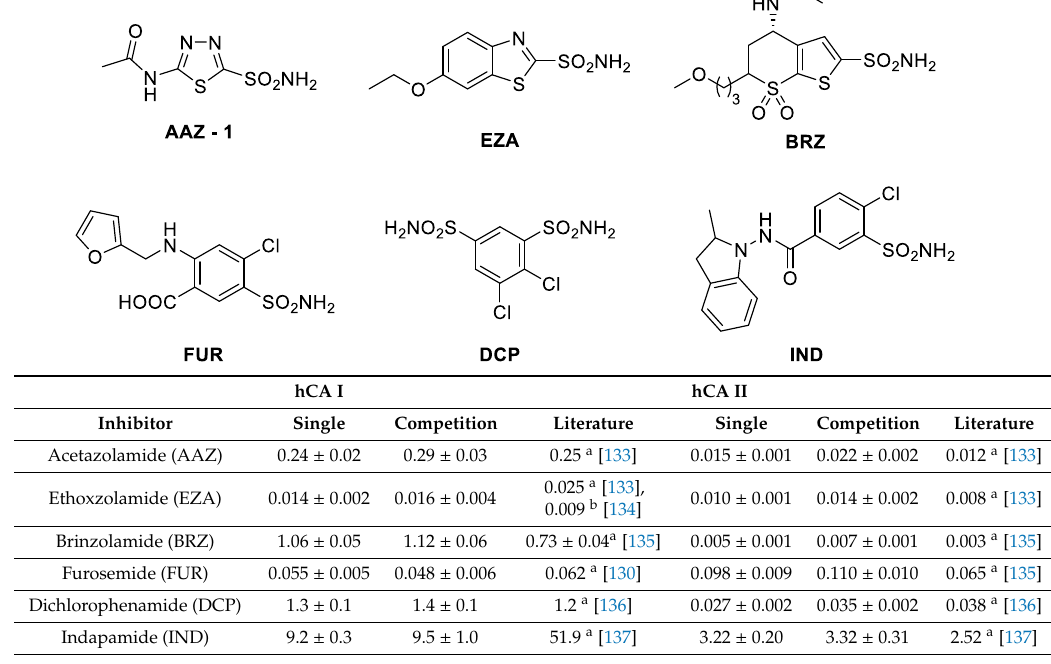
Table 1. Measured dissociation constants (μM) of six sulfonamides to human (h)CA I and hCA II using native mass spectrometry with nanoscale ion emitter tips in individual ligand–protein binding experiments (Single) and simultaneously in a competition experiment (Competition). Data adapted from Reference [130].